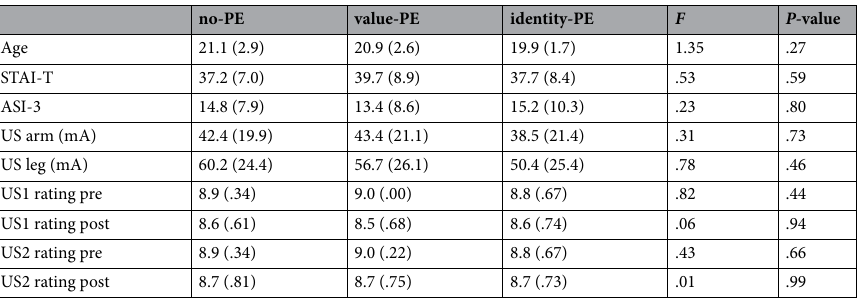
Table 1. Demographic information, mean (standard deviation, SD) of STAI-T and ASI questionnaire scores, US intensities and US intensity ratings (pre- and post-conditioning) for participants in the control, the value-PE and identity-PE group. There were no significant group differences as indicated by ANOVA with between-subject factor ‘group’ (F- and P